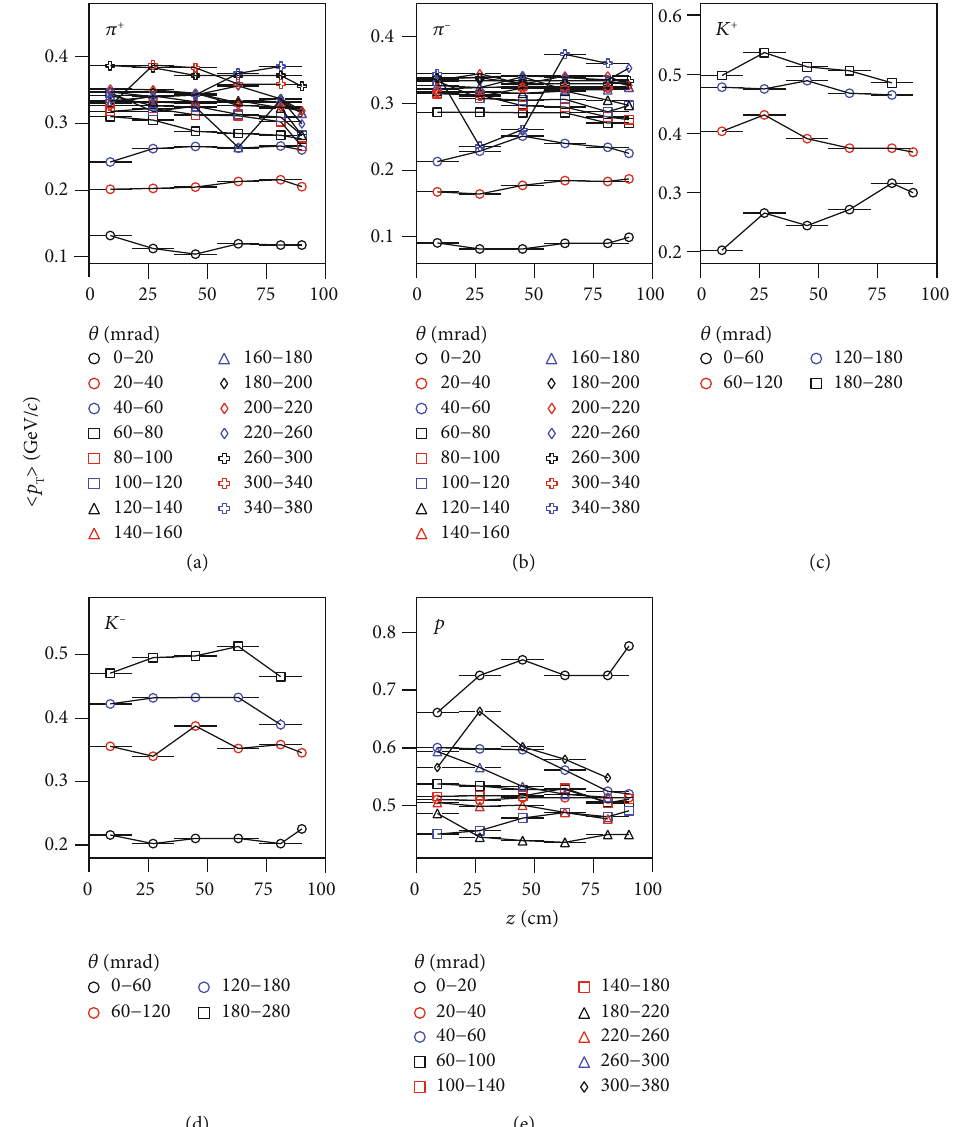
i on z , which are extracted from the data samples within di ff erent θ ranges for (a) π + , (b) π − , (c) K + , (d) K − , Figure 14: Dependence of h p T and (e) p